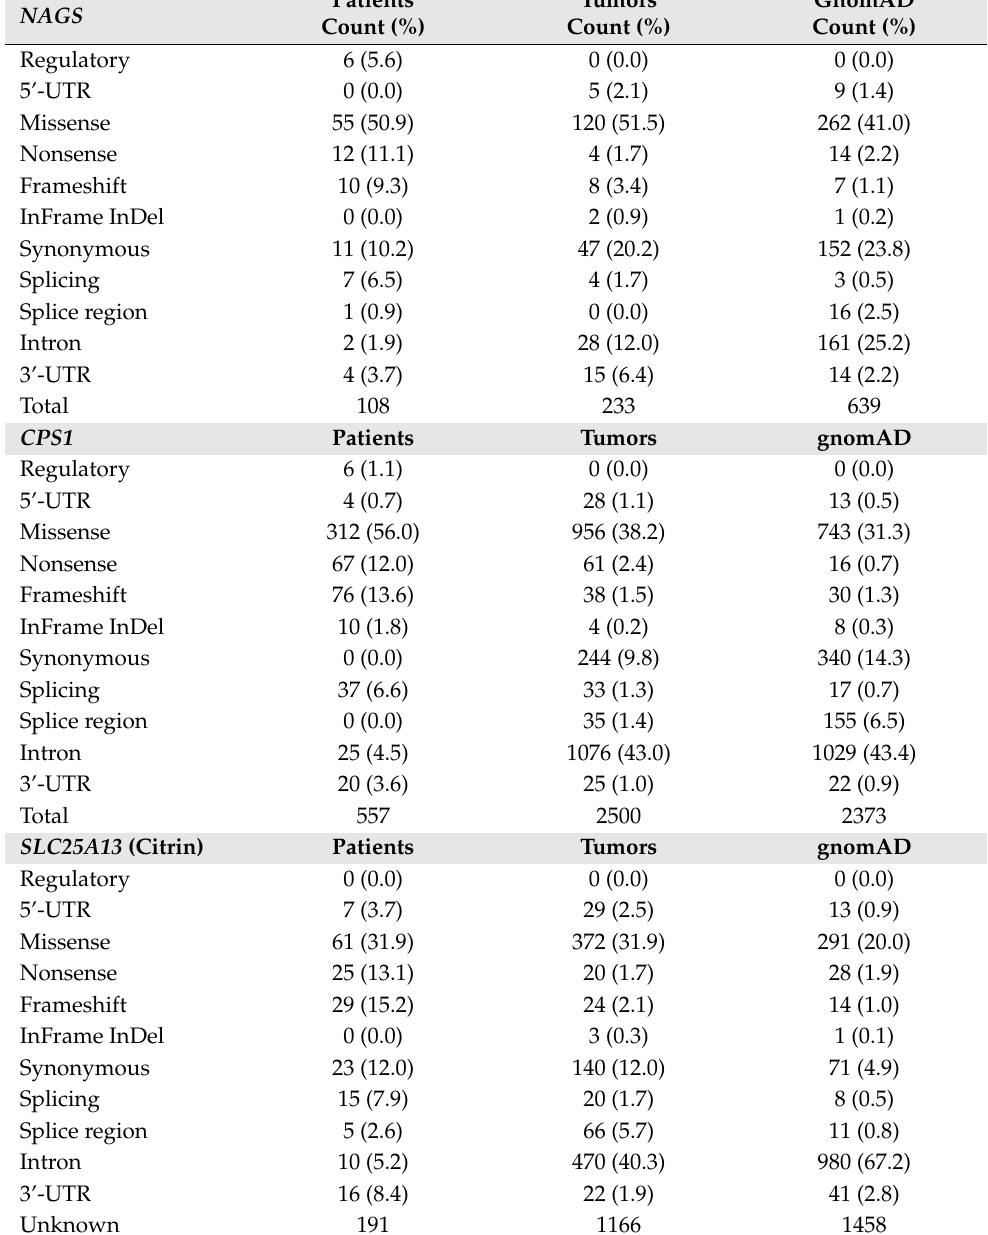
Table 2. Number and type of sequence variants found in NAGS , CPS1, and citrin genes in patients with NAGS , CPS1, or citrin deficiency, tumor samples, and individuals without rare genetic